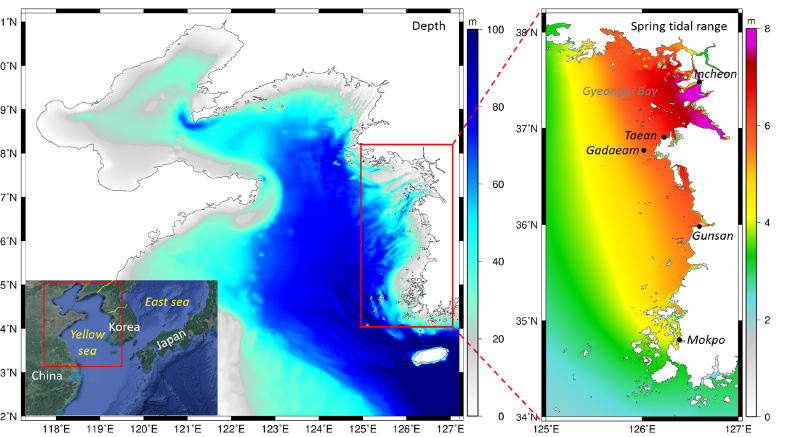
Figure 1. Map showing study area, WCK, with complex coastlines, shallow depth (bathymetry data from KorBathy30s [1]), and spring tidal range (computed as 2[M 2 +S 2 ]).